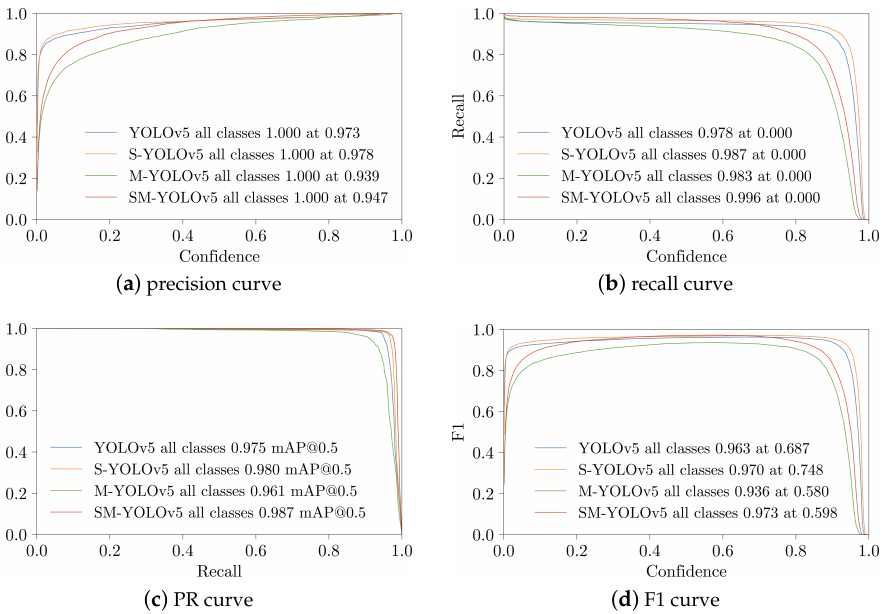
Figure 8. Visualization of the results from ablation experiments conducted using YOLOv5, S-YOLOv5, M-YOLOv5, and SM-YOLOv5